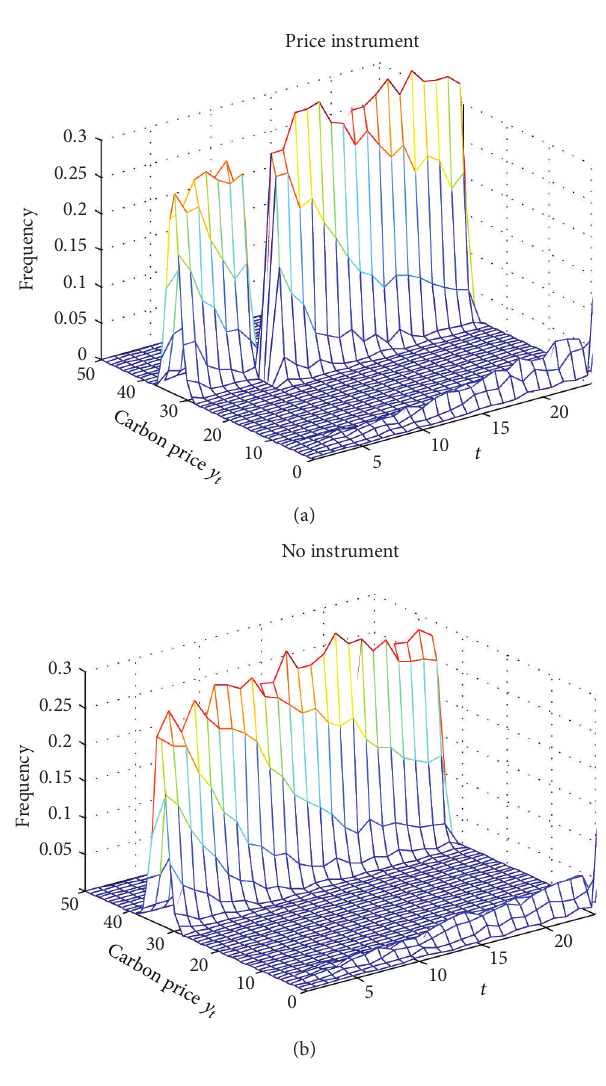
Figure 2: Carbon price frequency distribution diagram of upper threshold regulation using price